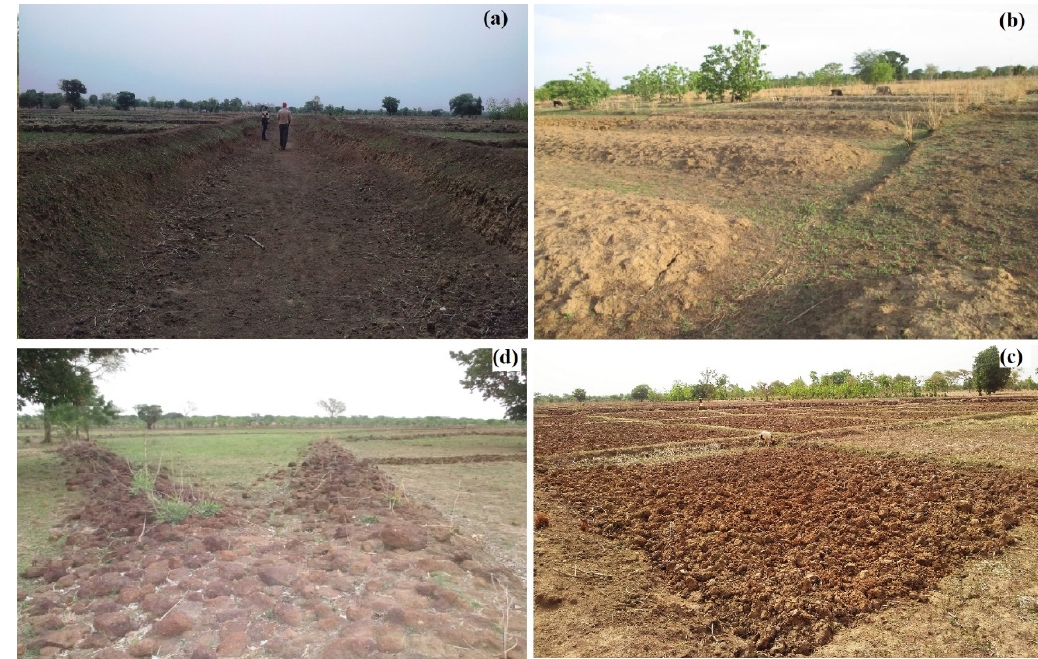
Figure 3. Different types of lowland development, including a rice field model with sprinkler drains ( a , b ), cyclopean concrete pouring dikes with a central cofferdam ( c ), and compacted clay bunds protected by geotextiles and rocks following the level curves with openings ( d ).